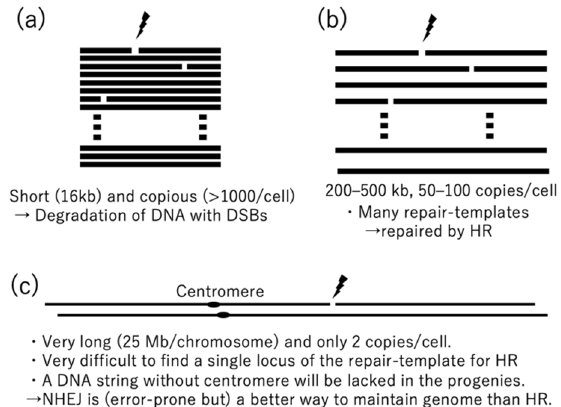
Figure 1. Comparison of double-strand breaks in mitochondrial and nuclear genomes. ( a ) Mam- malian mitochondria, ( b ) plant mitochondria, and ( c ) mammalian and plant